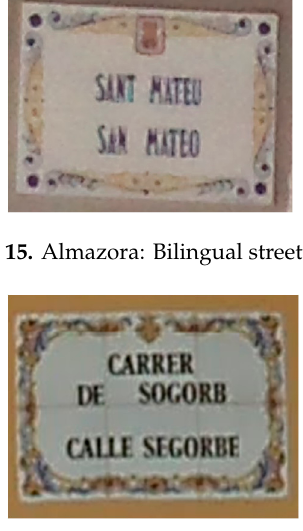
Figure 16. Almazora: Bilingual street name .